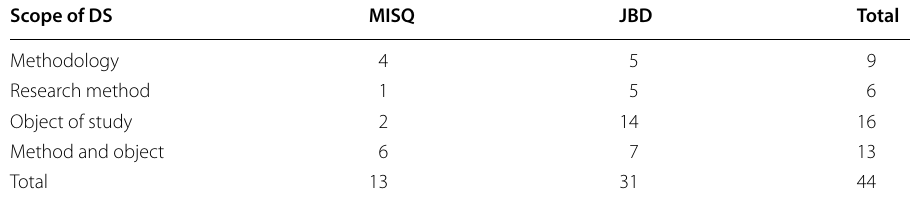
Table 4 Classification of analytics and data science studies: 2015–2019 Scope of